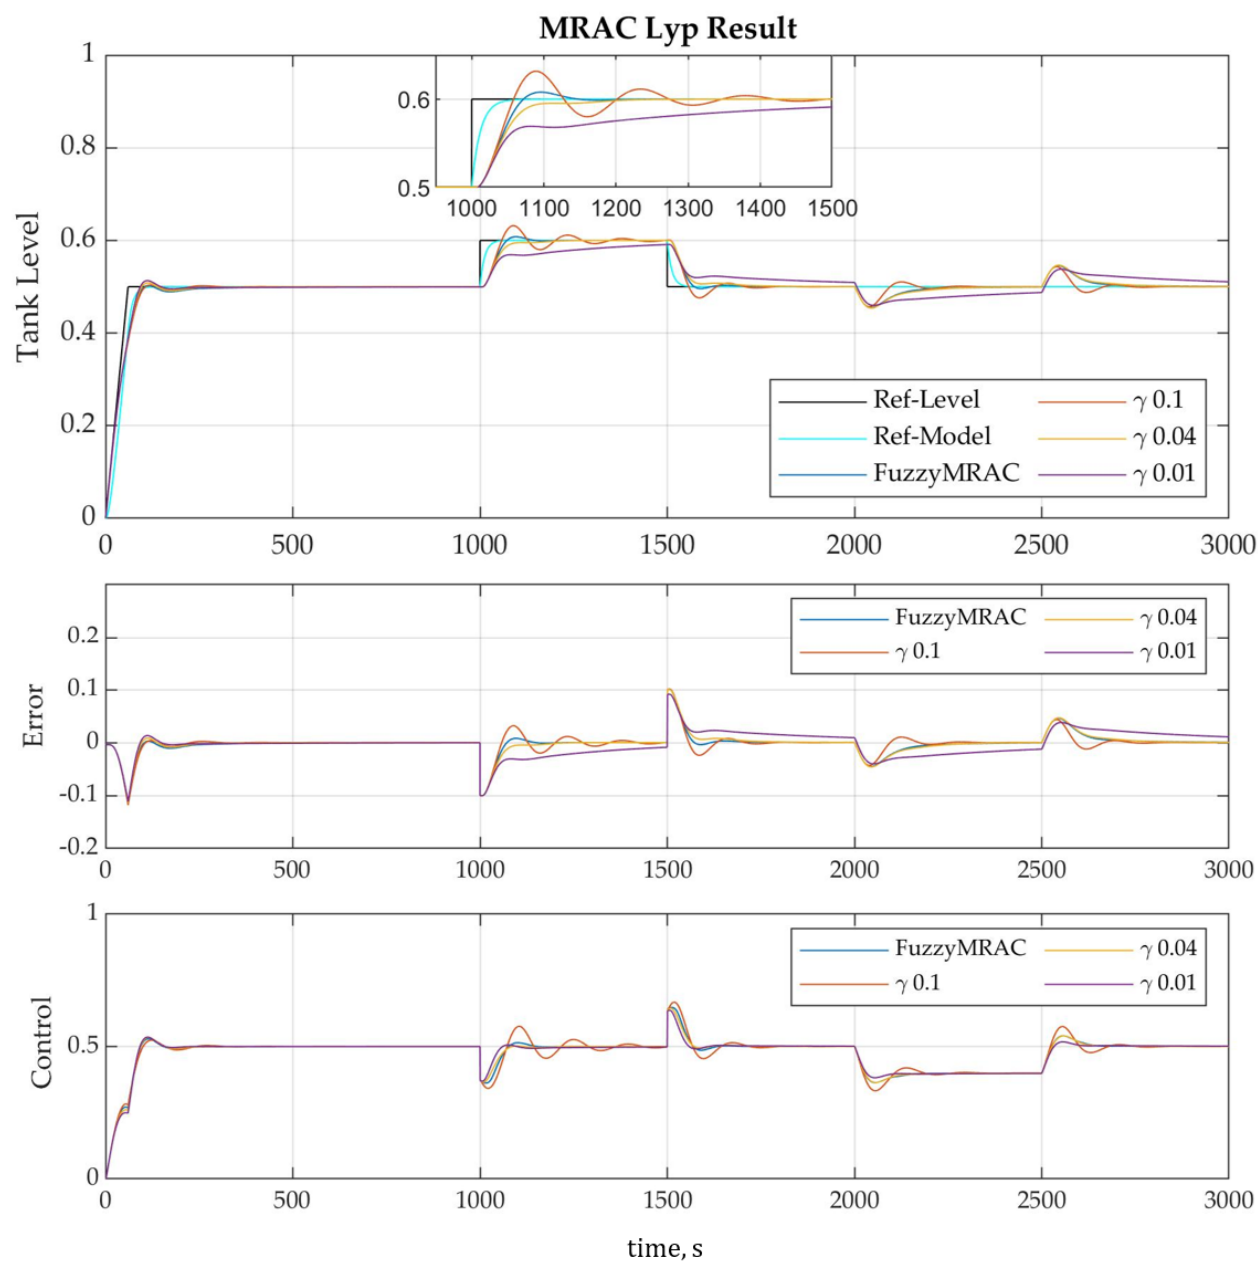
Figure 12. Tank level control for Lyapunov rule fuzzy MRAC and MRAC with different adaptation rates.